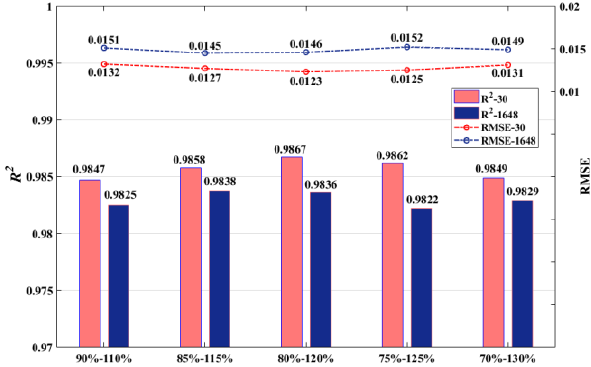
Figure 9. Tests for variation of generator/load power distribution.